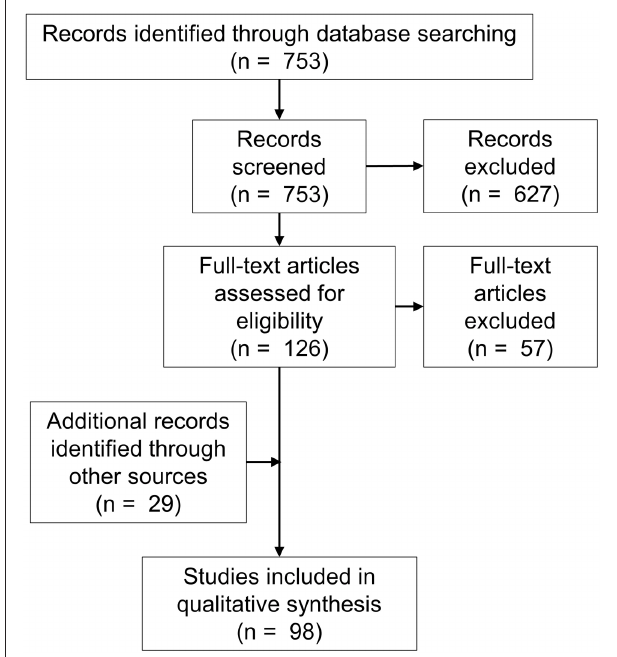
FIGURE 1 | PRISMA